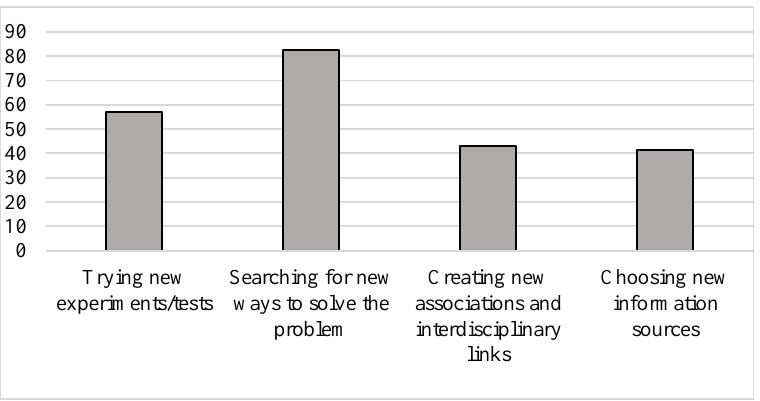
Fig. 3. Important creative thinking skills